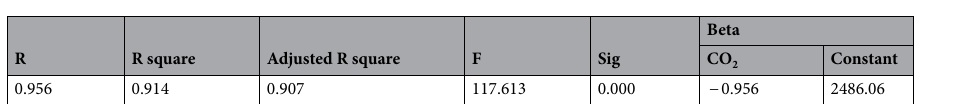
Table 2. Regression modeling between the total water storage and carbon dioxide